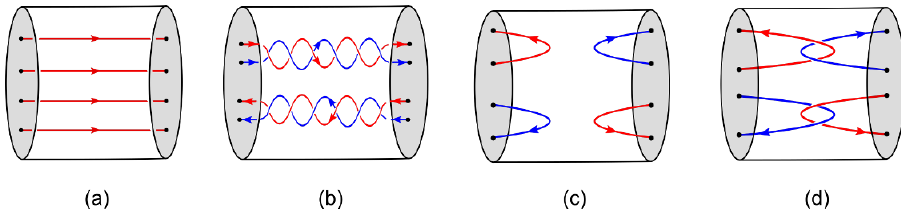
Figure 3 . Some of the entanglement results presented in [21] using the replica trick. States (a) and (b) are maximally entangled and hence the Bell states. State (c) is non-entangled or a product state while state (d) is non-trivially entangled